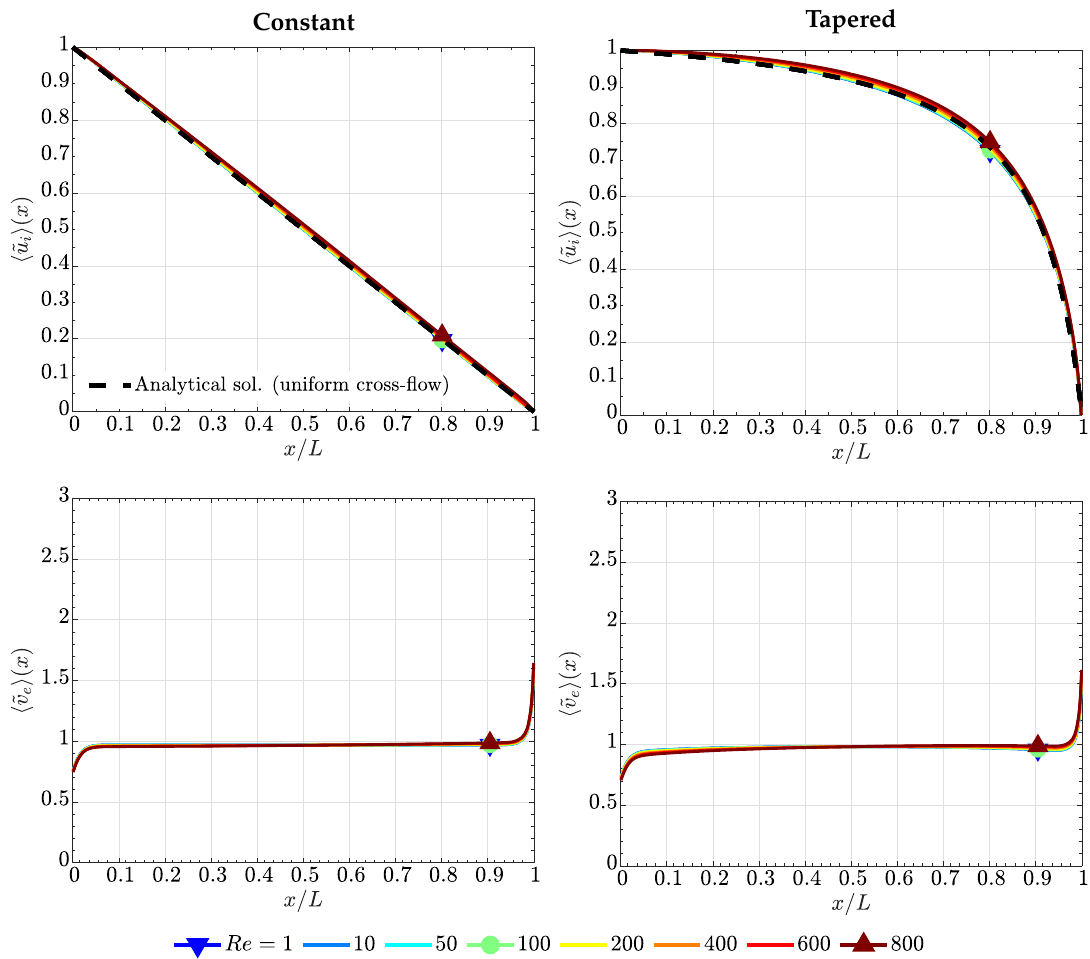
Figure 5. Variation of ( top ) the y -averaged axial velocity in the inlet channel, (cid:104) ˜ u i (cid:105) ( x ) , and ( down ) the y -averaged transverse velocity in the electrode, (cid:104) ˜ v e (cid:105) ( x ) , as a function of the along-the-channel coordinate, x / L , for Re = 1–800, corresponding to ( left ) the constant cross-section and ( right ) the tapered flow fields. Electrode permeability, K e = 10 − 12 m 2 ( γ ∼ 10 − 2 ) , and Λ =